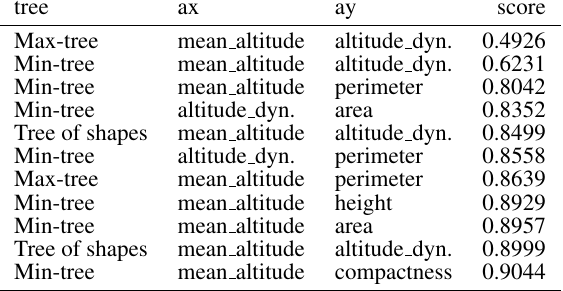
Table 2. 2D spectra intersection of gold panning and background (lower is better).